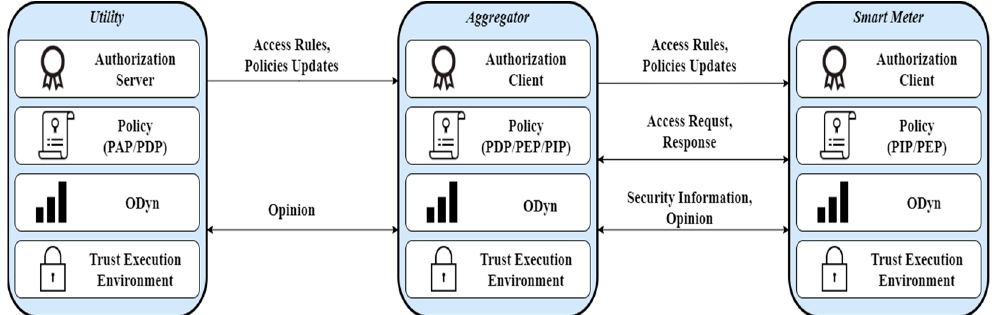
Figure 2. SAMGRID architectural components. Table 2. Main entities and roles participating in